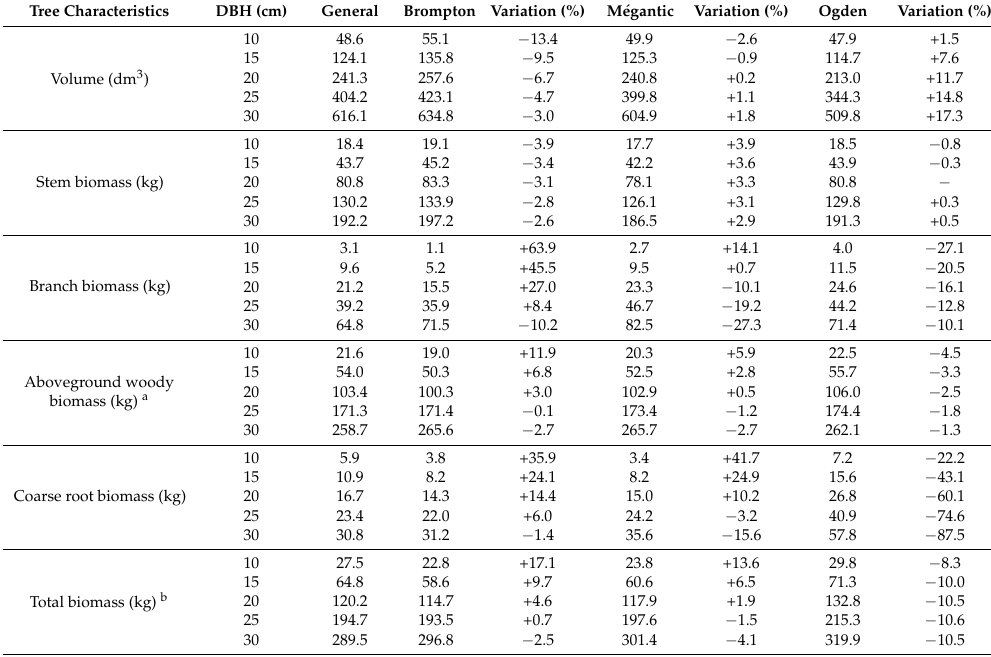
Table 7. Comparison of predicted values for different tree compartments calculated with the general and the site-specific models for trees with different DBH values. The percentage of variation associated with the use of the general model instead of the site-specific model is